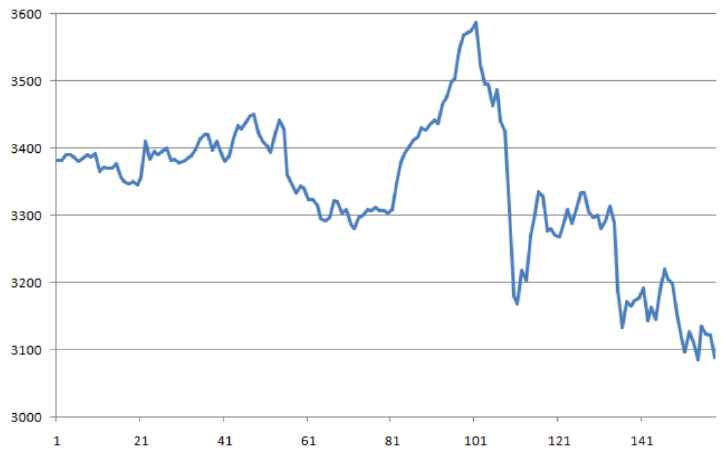
Fig. 8 The high price of training data.